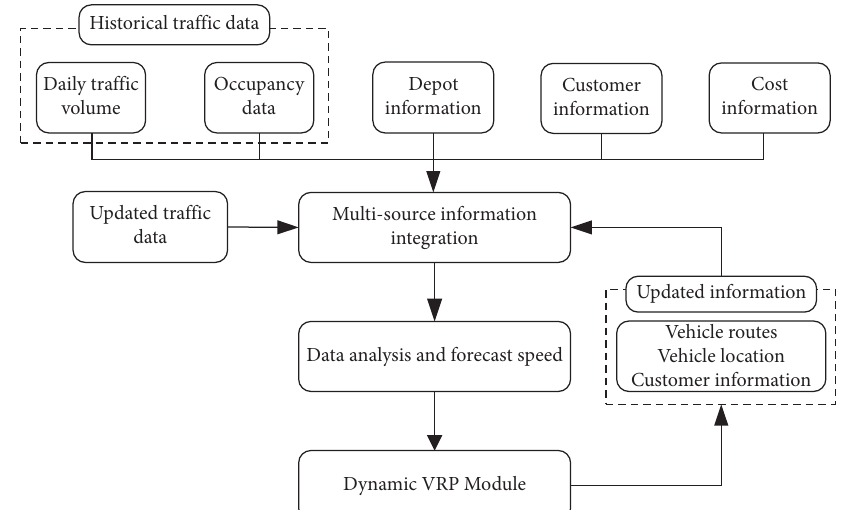
Figure 1: Information processing framework.